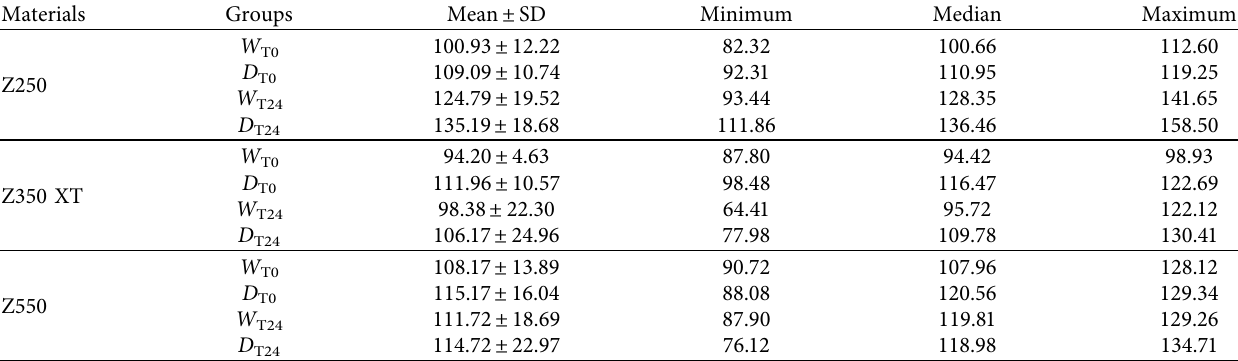
Table 2: Mean ± SD, minimum, median, and maximum values of fexural strength of the samples. Materials